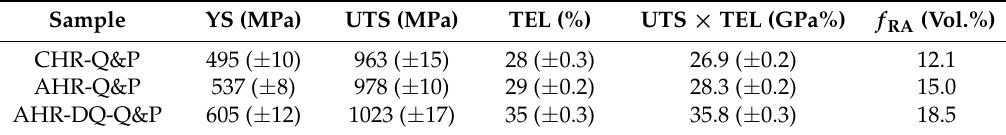
Table 1. Mechanical properties of experimental